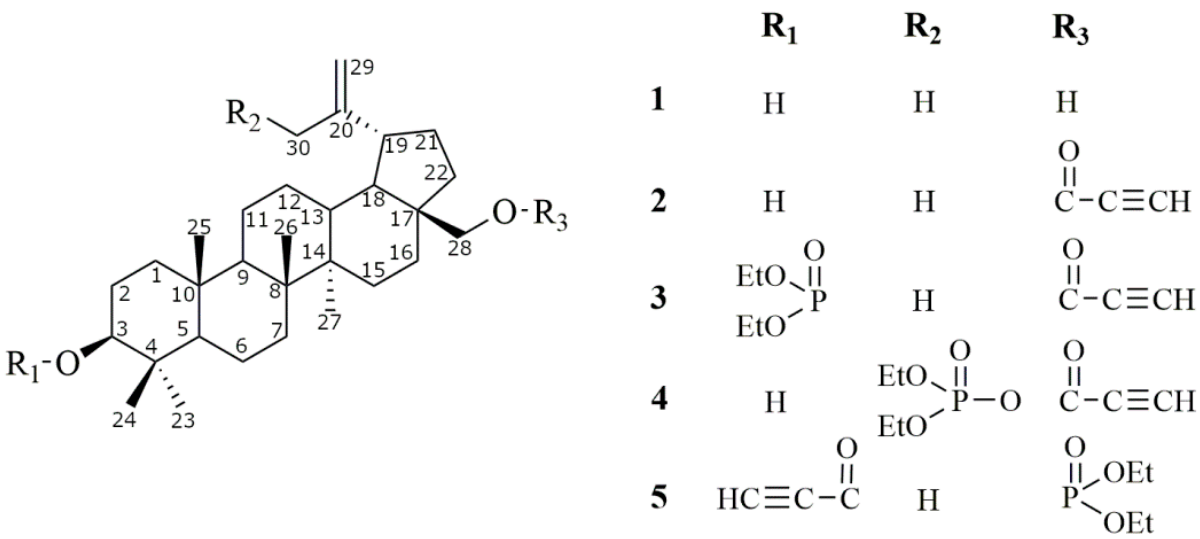
Figure 1. Chemical structure of betulin ( 1 ) and its four derivatives ( 2 – 5 ).